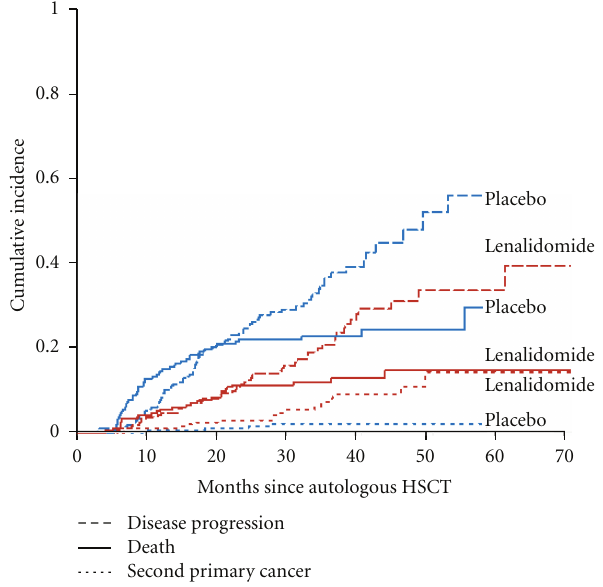
Figure 1: Competing risks in multiple myeloma patients. Cumula- tive incidence of second primary cancers, disease progression, and death for patients randomized to either maintenance lenalidomide or placebo post HDT/SCT in the CALGB 100104 trial. In placebo treated patients (in blue), the risk of death and disease progression far exceeds the risk of SPM. Reprinted with permission